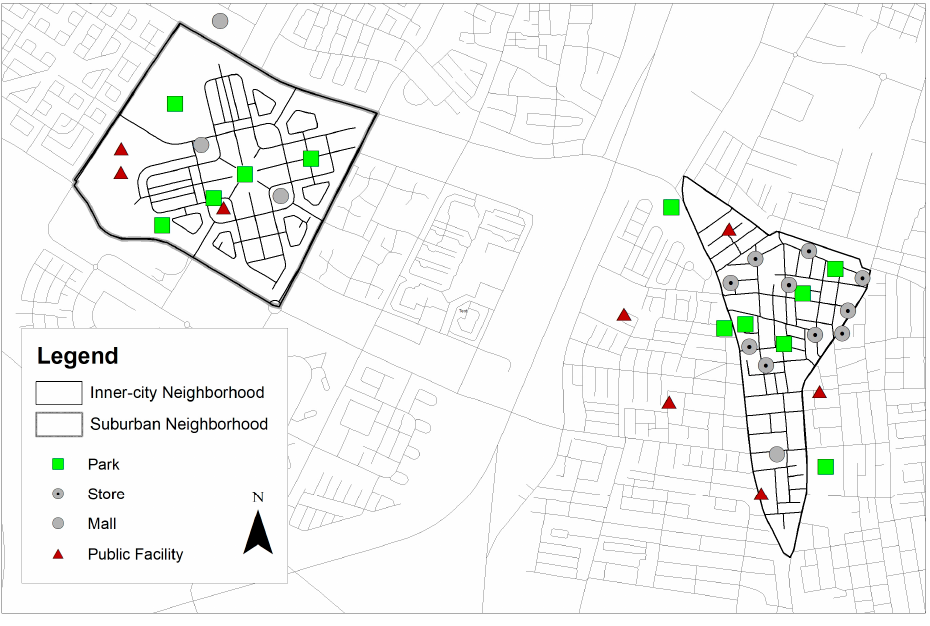
Figure 1. Reported play areas .